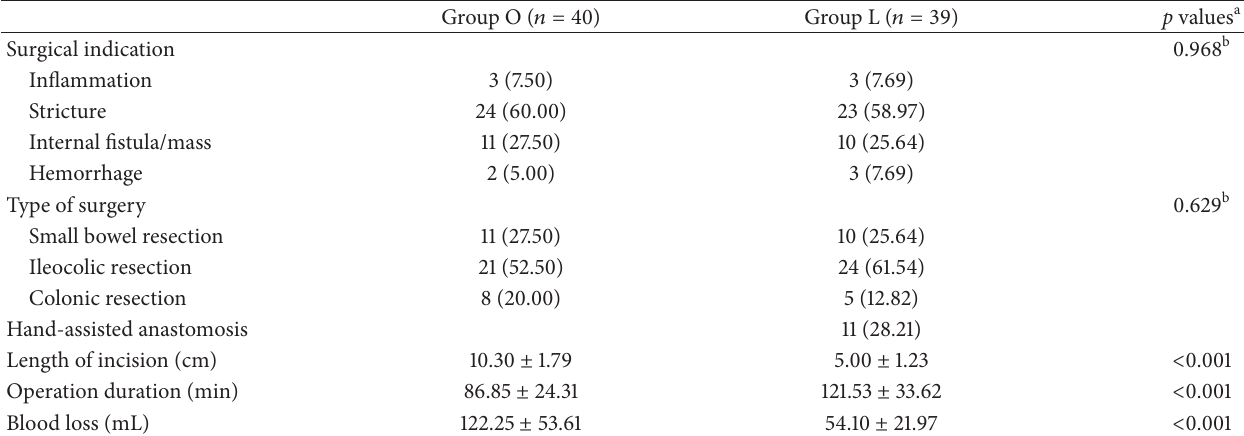
Table 2: Comparison of intraoperative data between groups.